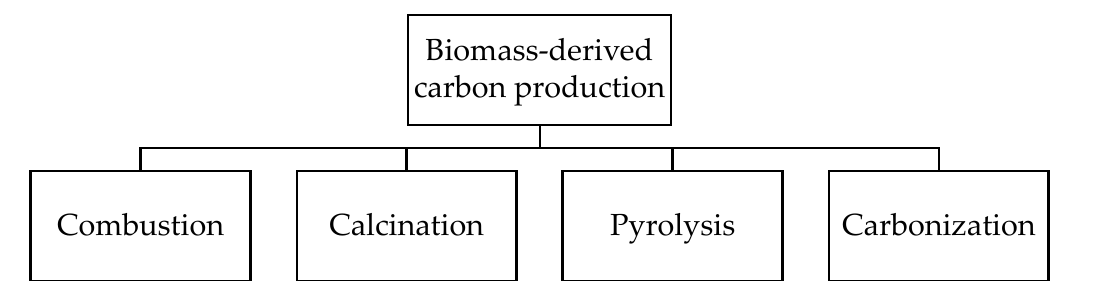
Figure 1. Main methods for biomass ‐ derived carbon production.